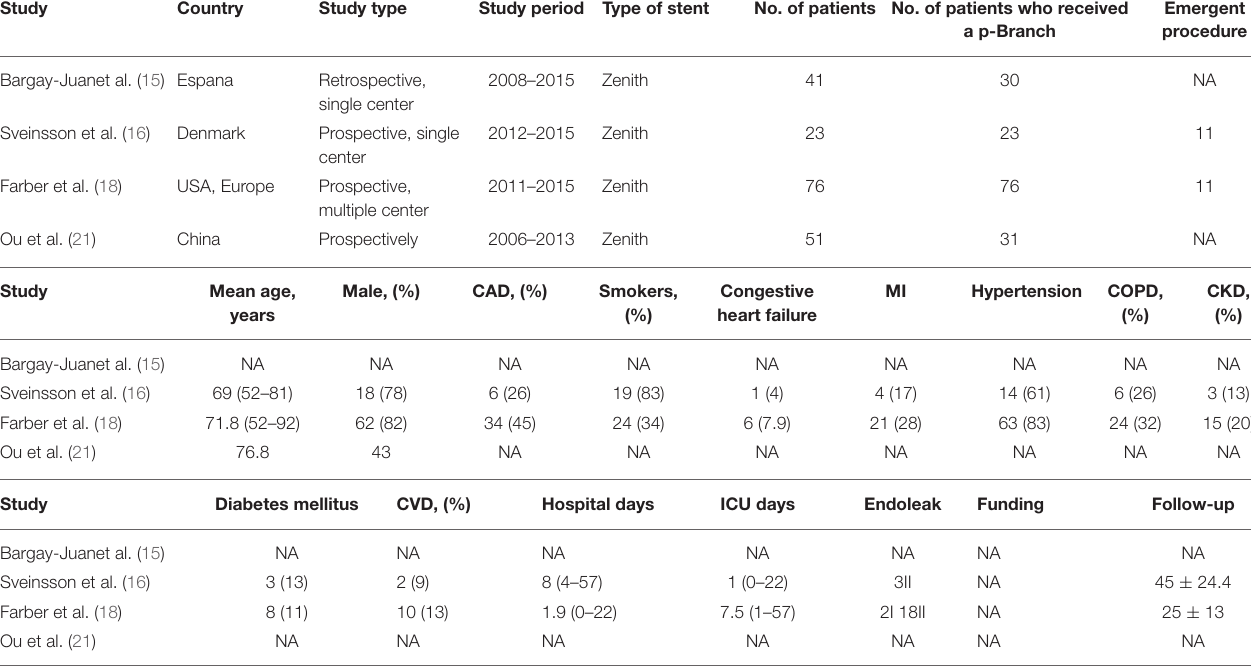
TABLE 2 | Baseline characteristics of studies not funded by Cook.